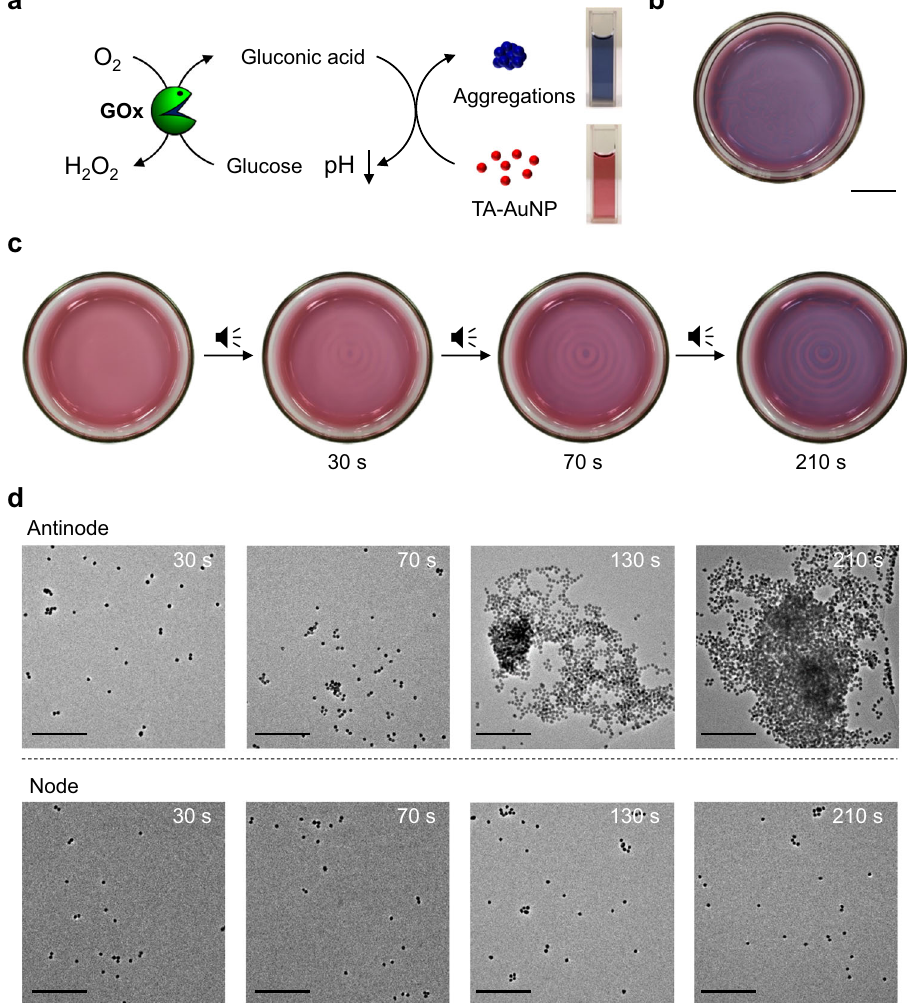
Fig. 4 Audible sound mediated spatiotemporal control over glucose/GOx/TA-AuNP cascade reaction. a Schematic representation of glucose/GOx/TA- AuNP cascade reaction. Here the color pattern is generated from the blue-colored aggregates of TA-AuNPs. GOx: glucose oxidase, TA-AuNP: thioctic acid- functionalized gold nanoparticle. b Random shaped pattern generated without applying audible sound (scale bar is 1.5 cm). c Time-dependent changes of a concentric ring pattern generated with applying 30 Hz of audible sound. d Time-dependent TEM images of TA-AuNP solution taken at the antinodal (top) and nodal (bottom) positions of the colored pattern at 30, 70, 130, and 210 s, respectively (scale bar is 200